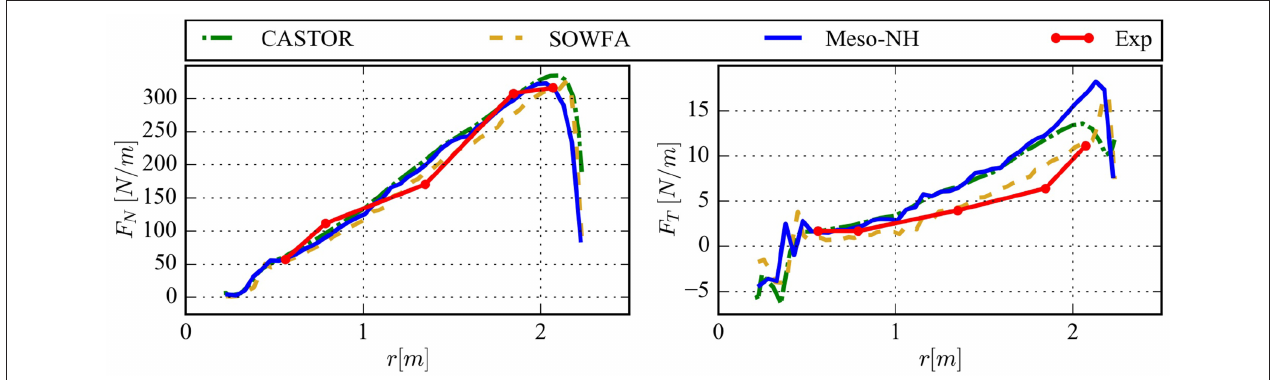
FIGURE 2 | Comparison of computed normal F N and tangential F T forces per unit length along the blades for the 10 m/s case with the New MEXICO experiments (Boorsma and Schepers, 2014), CASTOR and SOWFA simulations (Blondel et al.,